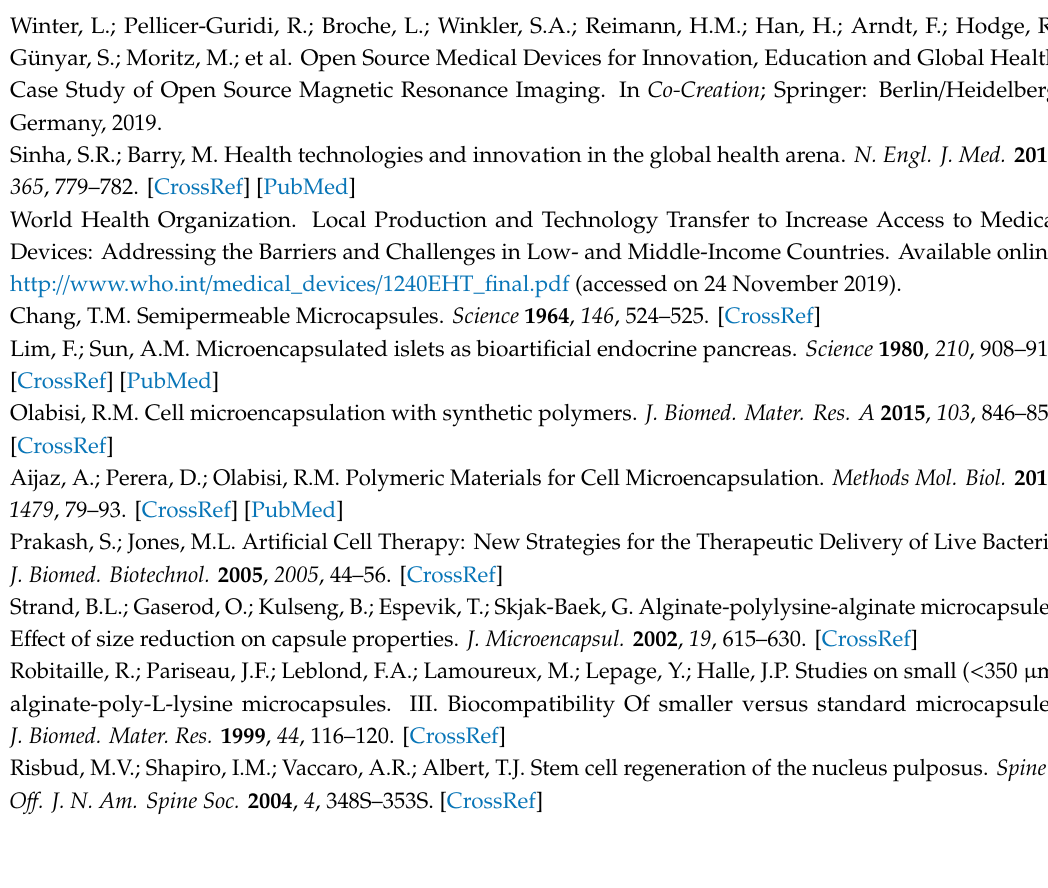
Figure S1: Cell encapsulation equipment produced in a 3D print. Measurements are displayed in millimetres (mm) or centimetres (cm); Figure S2: The sodium alginate microcapsules were evaluated by scanning electron microscopy-SEM (Hitachi TM 3000) fixed on carbon tapes at 5 kV, with magnification from 120 × (A), 150 × (B) and 250 × (C). Thus, was not possible to see the pores of the polymer; Figure S3: Viability of micro-encased cells (HepG2) up to 72